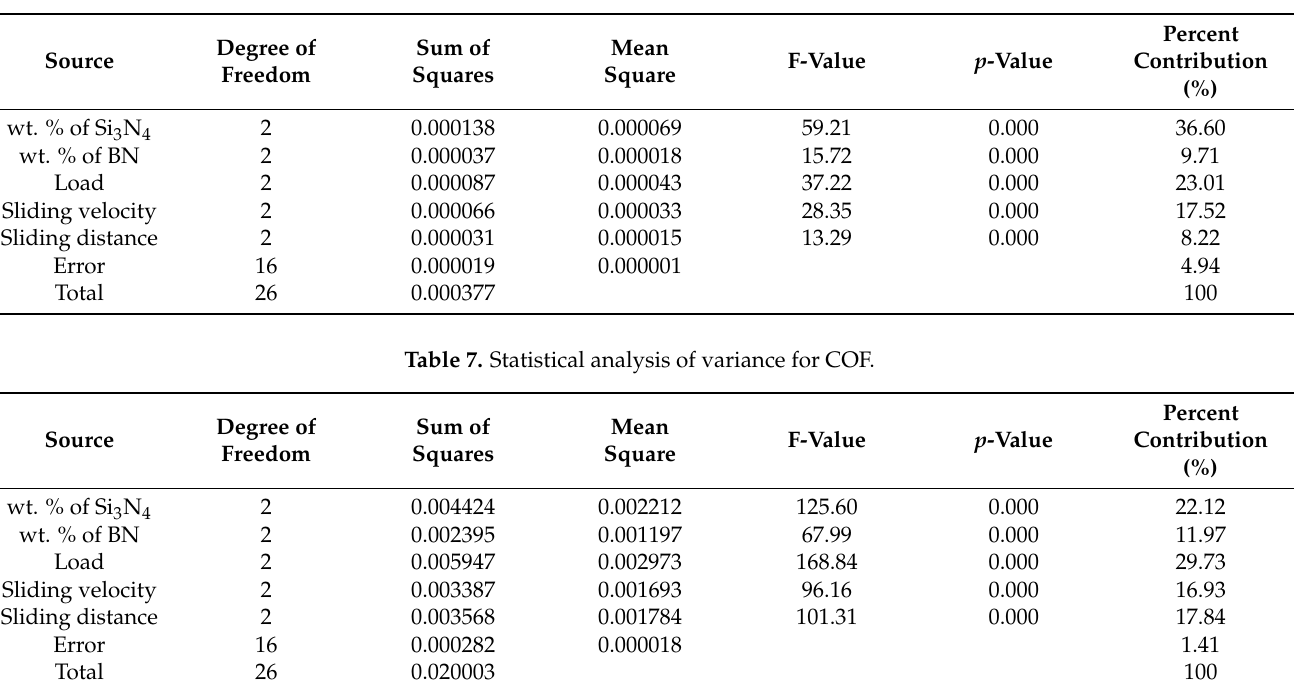
Table 6. Statistical analysis of variance for wear rate.